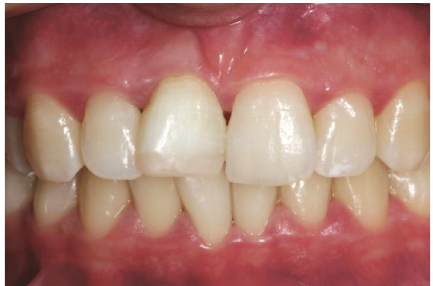
Figure 6: Final result after bleaching